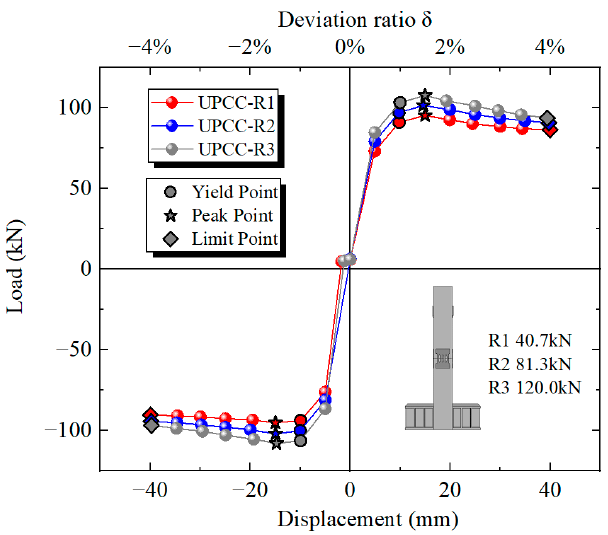
Figure 17. This is a figure. Schemes follow the same formatting.